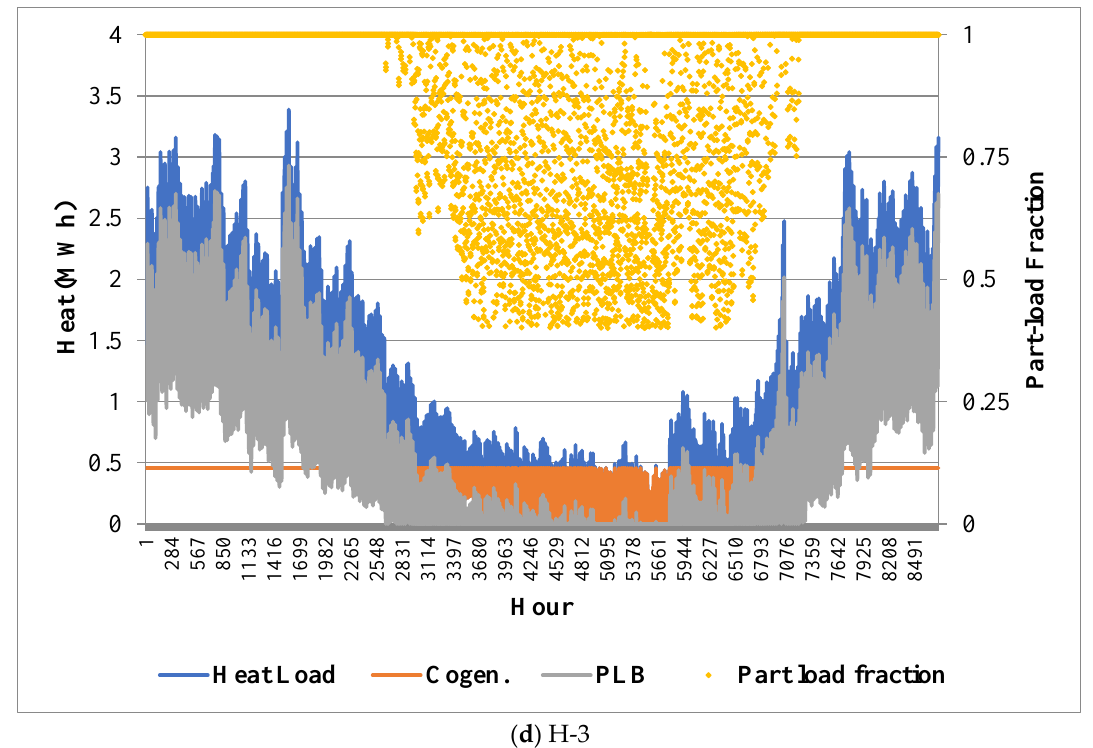
Figure 7. Annual hourly heating demand and supply profiles by facility for Case A.